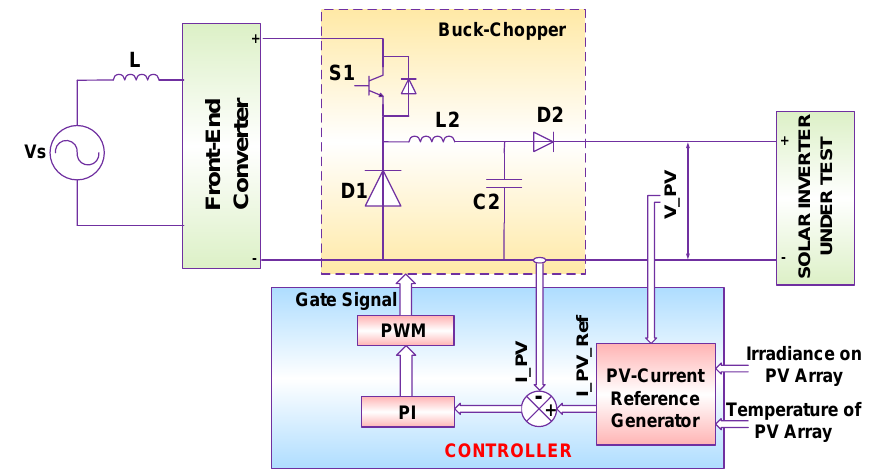
Figure 6. Control Block diagram of a DC-DC Converter.